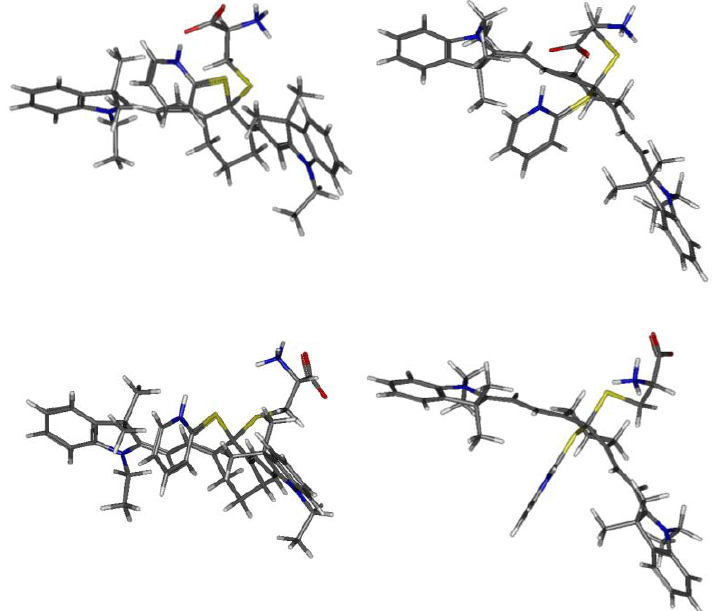
Figure 5. Optimized structure of the tetrahedral intermediate resulting from the nucleophilic addition of Cys to 1 (PCM-ωB97XD/6-31+G(d)), Top : cyclic intermediate, Bottom : acyclic intermediate, Left : side view, Right : top view. See Movies 2 and 3 for an animated version of both structures.